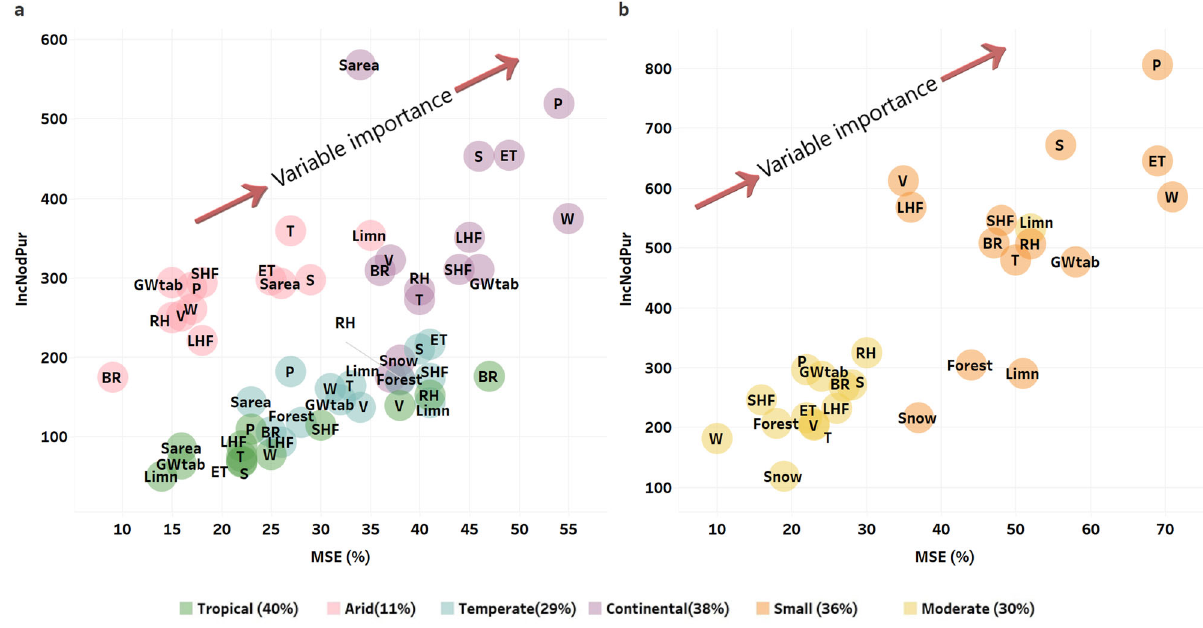
Fig. 4 Determinants of evaporative isotopic enrichment of global lakes. Random forest model results for variables that control the evaporative enrichment in lakes ( Δ L-P δ 18 O) with respect to climatic zone ( a ) and lake size ( b ). Model accuracy was tested using the Mean Decrease Accuracy (MSE, %) and the Mean Decrease Gini (IncNodPur, y -axis). Environmental variables used in the random forest model: Bowen ratio (BR, dimensionless), evapotranspiration (ET, mm), forest coverage in the catchment (Forest, %), groundwater table (GWtab, cm), catchment limnicity (Limn, %), latent heat fl uxes (LHF, W/m 2 ), precipitation amount (P, mm), relative humidity (RH, %), lake surface area (Sarea, km 2 ), sensitive heat fl uxes (SHF, W/m 2 ), snow coverage in the catchment (Snow, %), solar radiation (S, kJ/m 2 ), air temperature ( T , °C), vapor saturation (V, kPa) and wind speed (W, m/s). Model performance by zone and lake size ( R 2 ) is presented as % in the legend. Variable importance is indicated by the arrow